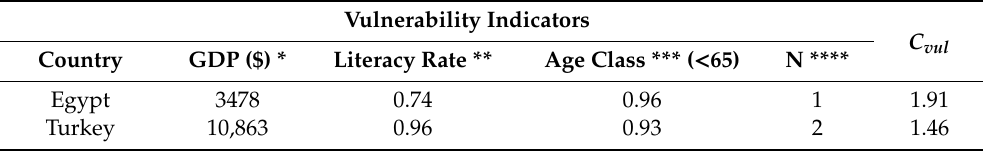
Table 2. Vulnerability coe ffi cients for Egypt and Turkey